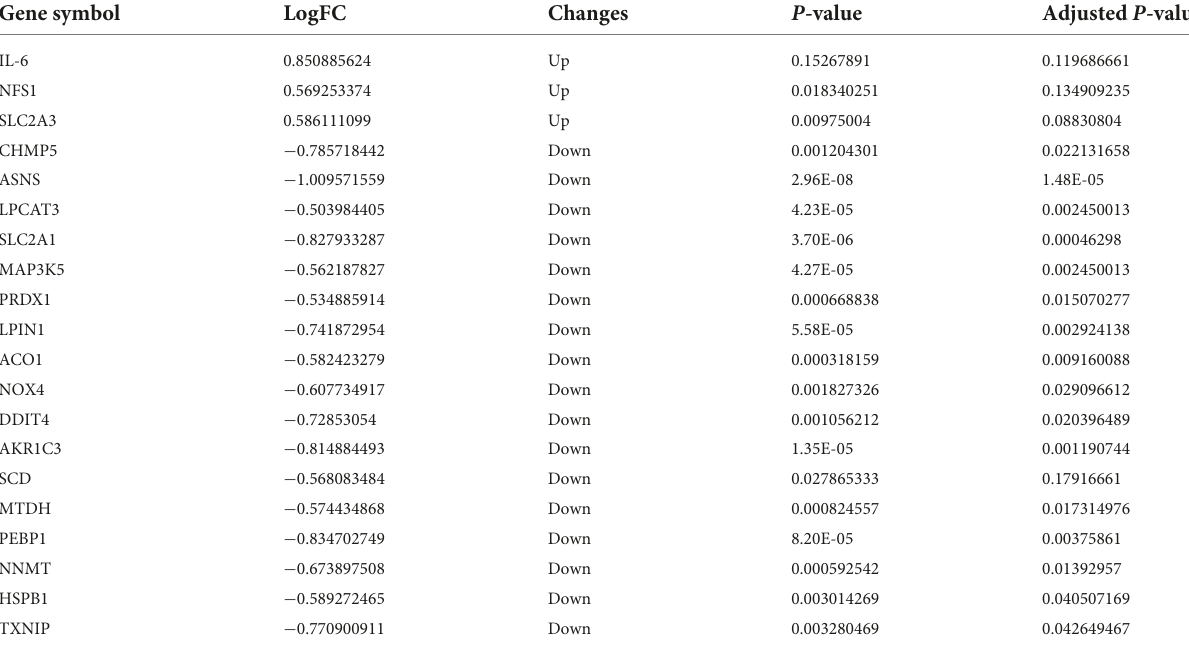
TABLE 3 The 20 differentially expressed ferroptosis-related genes identified in AAA samples compared with healthy